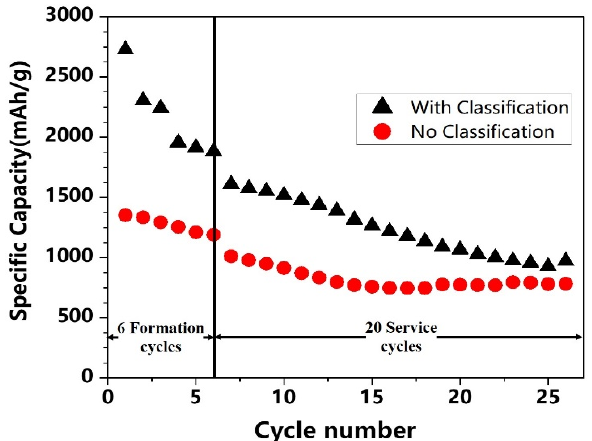
Figure 3. A comparison in the specific capacity as a function of cycle numbers between the cell made of the smallest size group of Si@void@C powder and the cell made of Si@void@C powder without particle classification. Both cells have the same formation and service cycles. See the text for details.